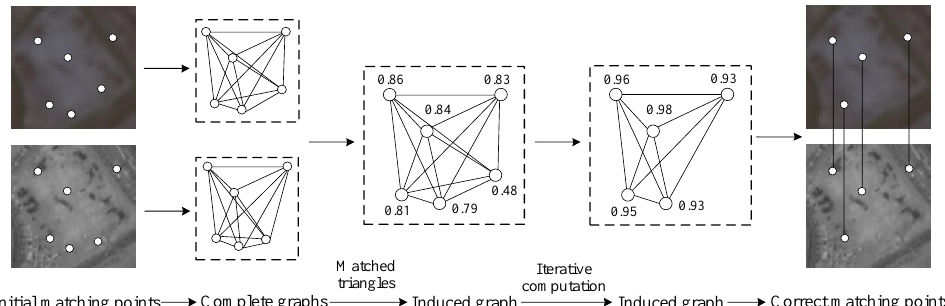
Figure 1. The workflow of COM graph.